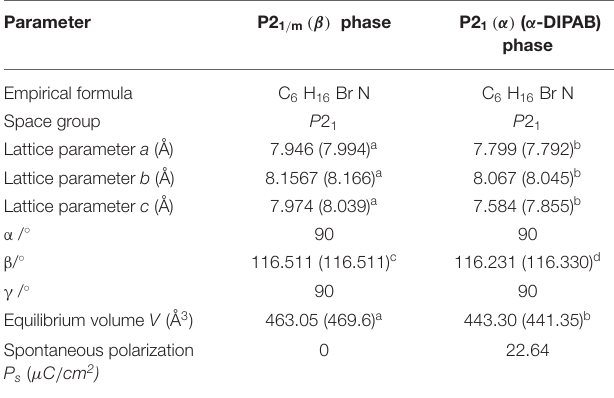
TABLE 1 | The optimized lattice parameters of P 2 1 / m (β) and α − DIPAB phases of DIPAB